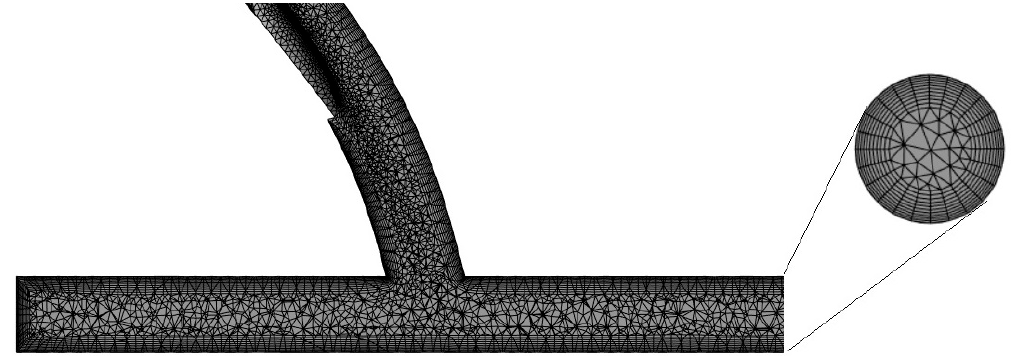
Figure 3. Hybrid mesh generated for the discretization of the computational model.